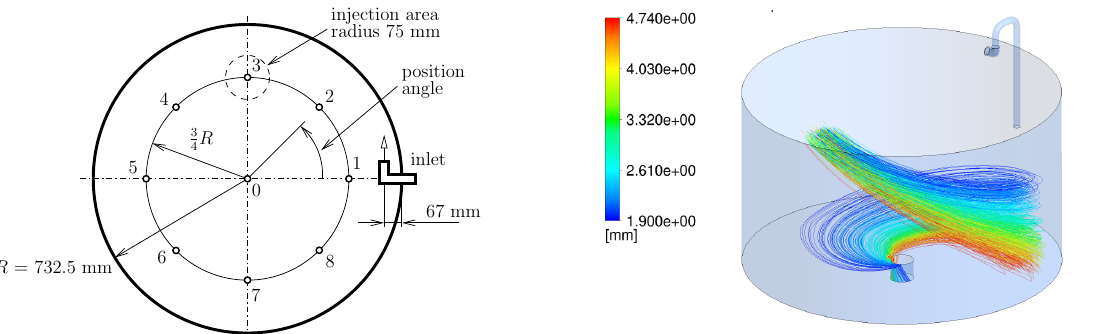
Figure 11. ( left ) Positions of pellet injections 0–8 compared in our simulations (see Table 5). Notably, 500 particles were injected in a circular area of radius 75 mm around these points (group injection type + staggered positions in ANSYS Fluent). ( right ) Illustration of TM0 pellets trajectories injected at position 5. Different colors represent particle diameters (based on the Rosin–Rammler distribution